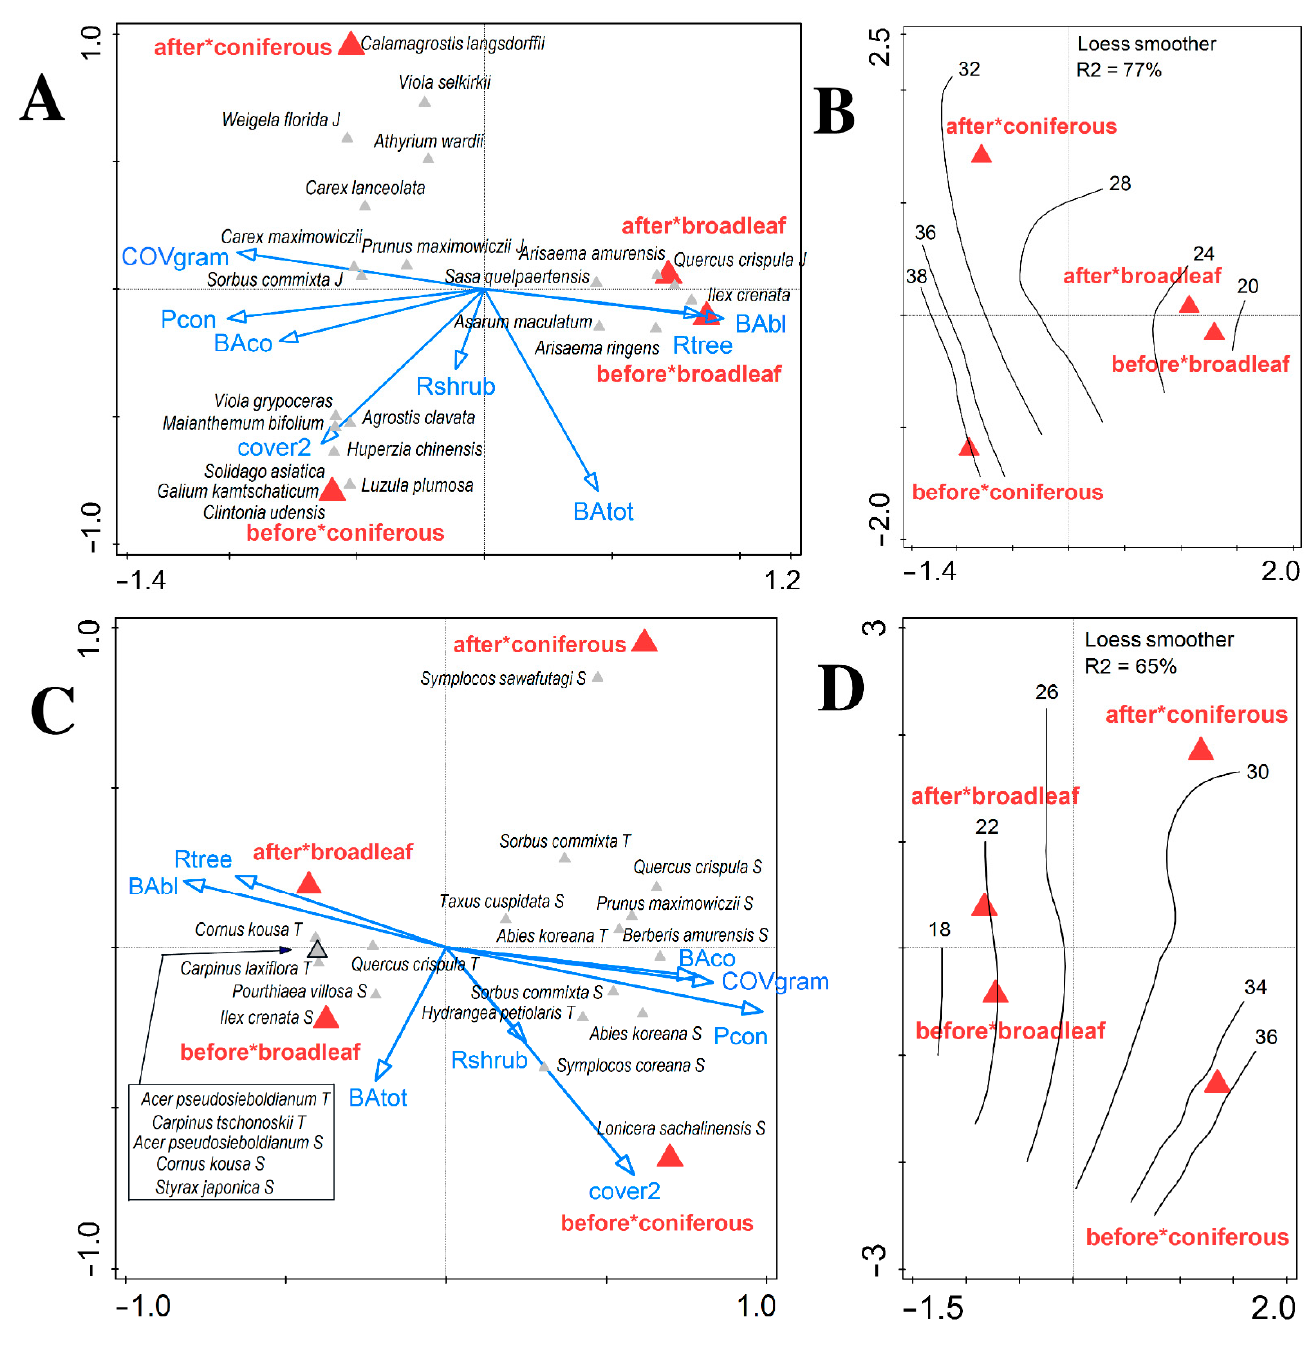
Figure 2. Ordination analyses (CCA1a, b, Table 2) showing temporal shifts in species composition among herbs ( A , B ) and shrubs and trees ( C , D ) in broadleaf and coniferous forests (36 permanent plots) before and after typhoons for the best fitting species together with the loess smoothed species richness isolines and selected stand variables (used as supplementary variables and represented by blue arrows; for abbreviations, see Table 1). Pgramin = graminoid fraction; T = tree layer; S = shrub layer; J = woody juveniles in the herb layer; no index =